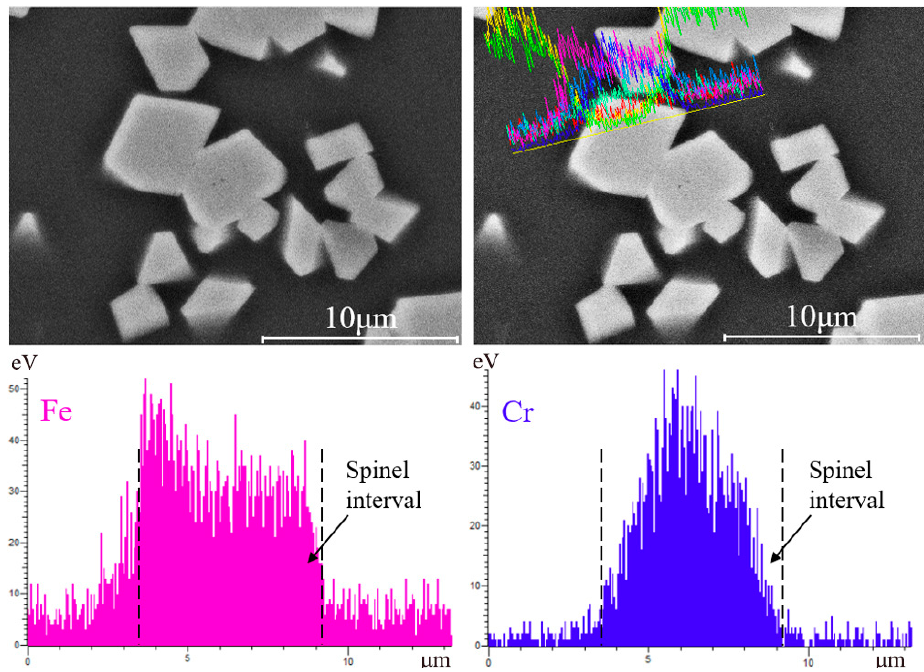
Figure 8. Distribution of Fe and Cr elements in spinel crystal in the 12 wt%